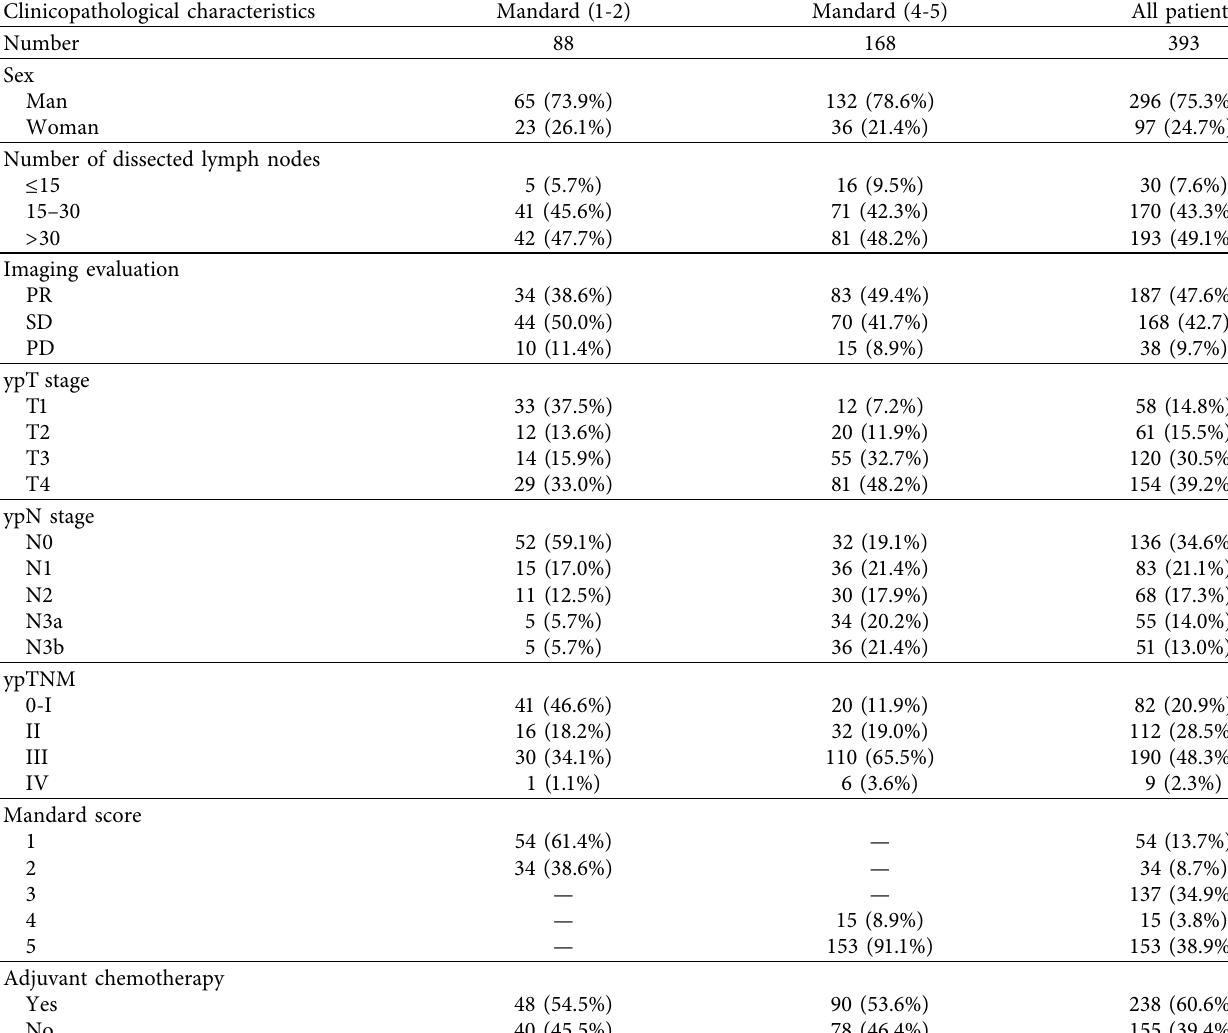
Table 1: Clinicopathological characteristics for all